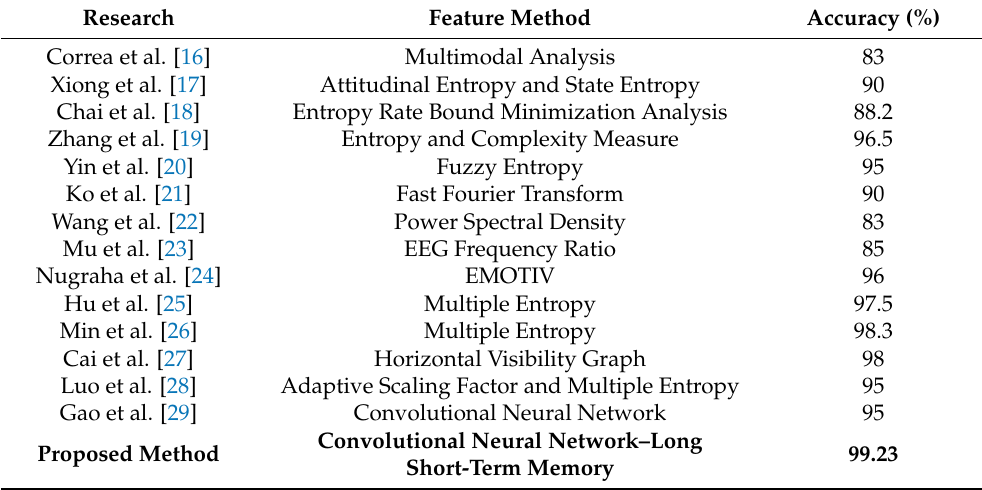
Table 3. Performance of the suggested method compared to different two-stage classification